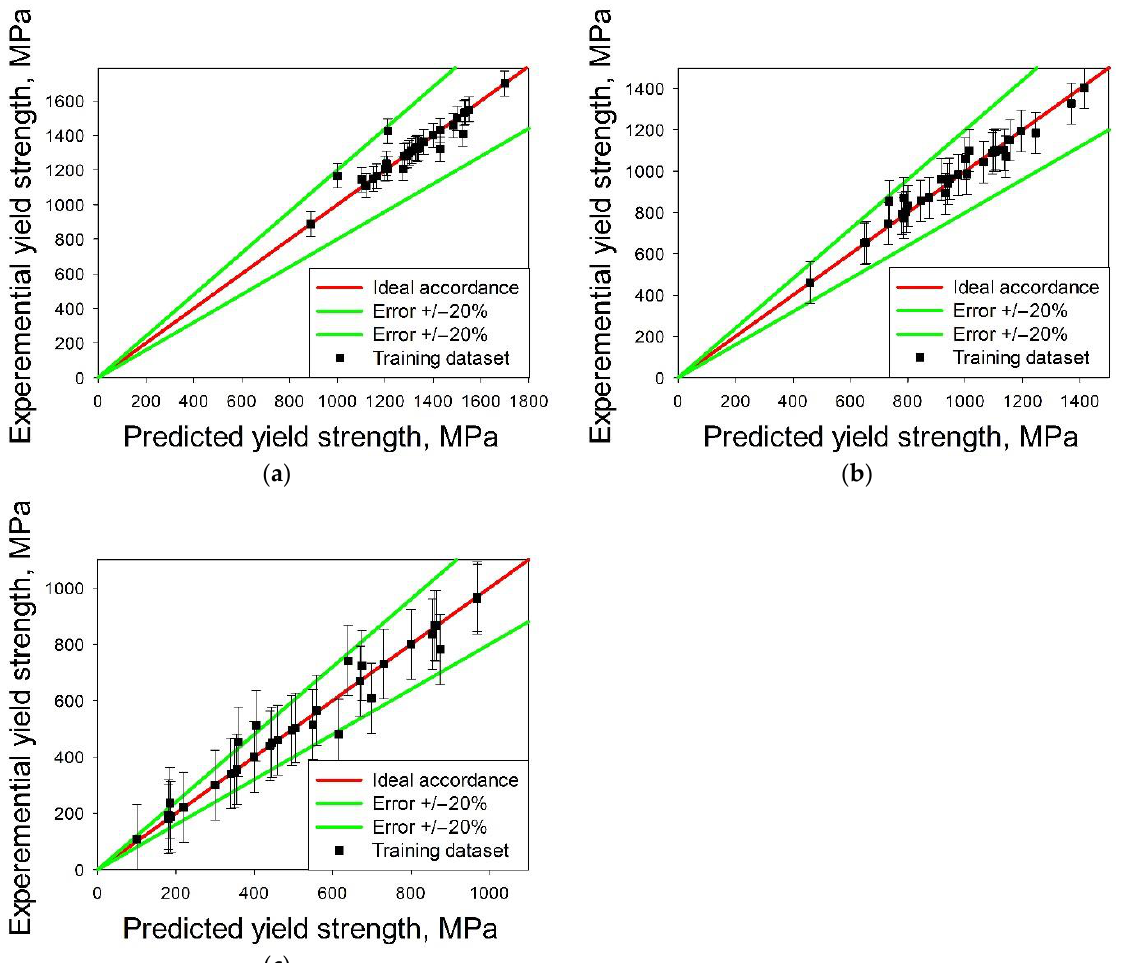
Figure 5. Experimental and predicted values of yield strength at 20 ◦ C ( a ), 600 ◦ C ( b ) and 800 ◦ C ( c ) for training dataset. The predicted values were obtained using the svr.rbf surrogate model.